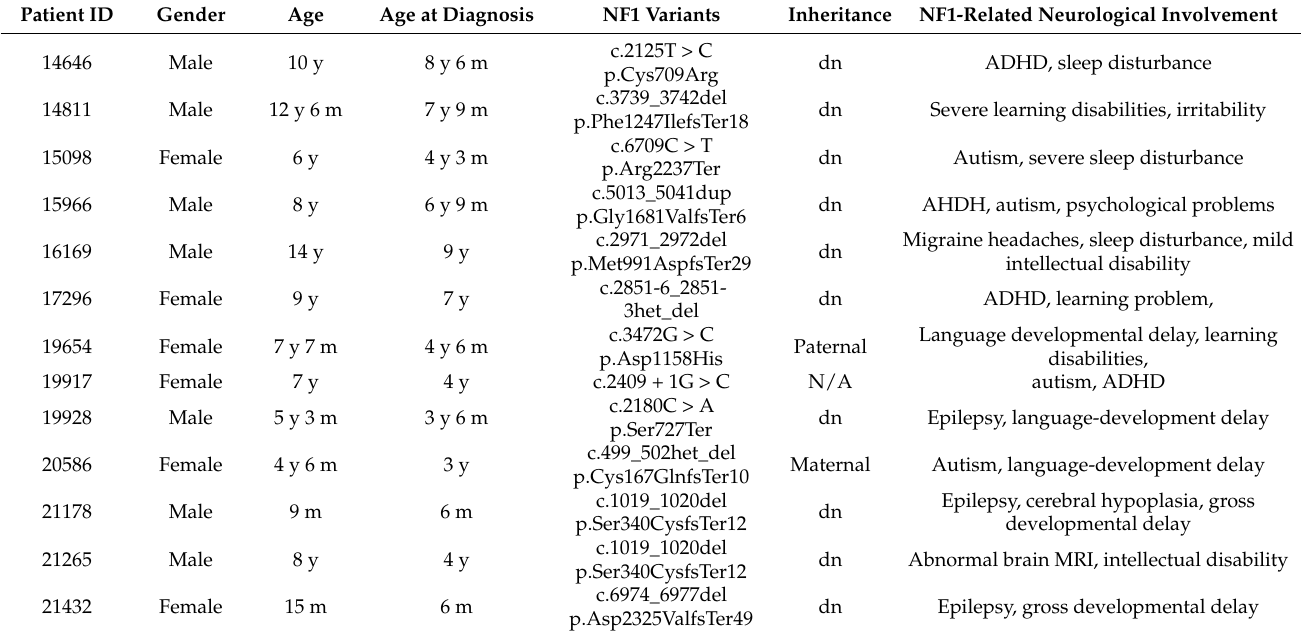
Table 1. NF1 variants and related neurological involvement in